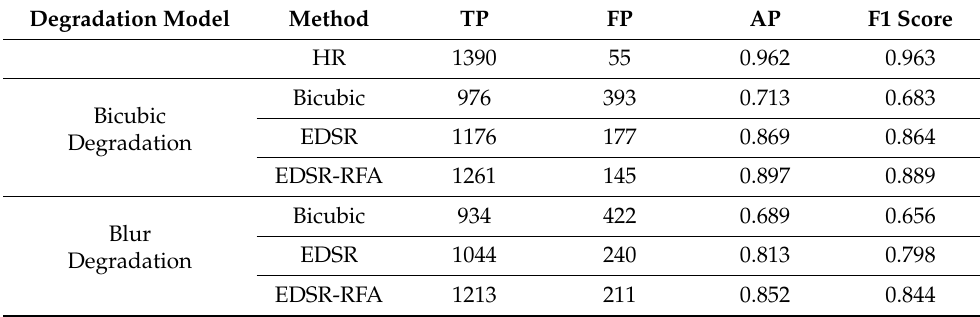
Figure 3. An illustration of the results provided by EDSR and EDSR-RFA: high-resolution (HR) image at the top left has a ground resolution of 5 cm/pixel while the LR version was generated using a scale factor of 8, which corresponds to a ground resolution of 40 cm/pixel, image super-resolution at 5 cm/pixel using bicubic interpolation, EDSR with four residual blocks and EDSR with residual feature aggregation (EDSR-RFA). Top: full image 512 × 512 pixels, Bottom: the zoomed image of 100 × 100 pixels showing a black car. Table 1. Vehicle detection using YOLOv3 (Confidence and IoU threshold = 0.25): comparing re- sults for HR images, a scaled image with a scale factor 8 × using Bicubic interpolation, EDSR, and